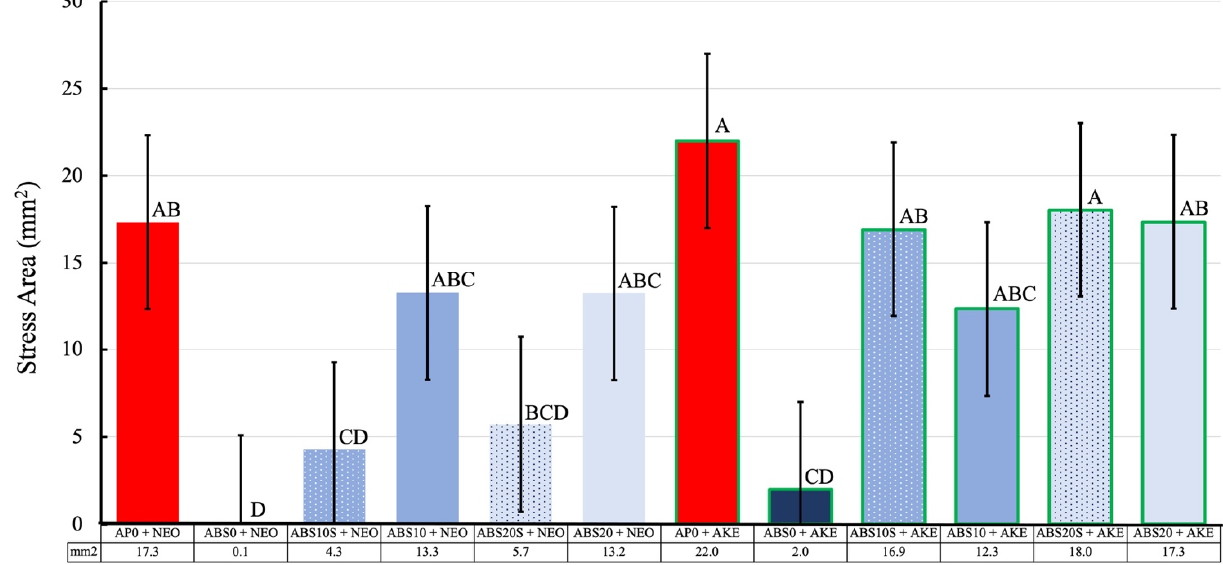
Figure 8. The impressed area of the maximum stress of various specimens obtained from the shock absorption test. The values of the same letter were not significantly different ( p > 0.05).